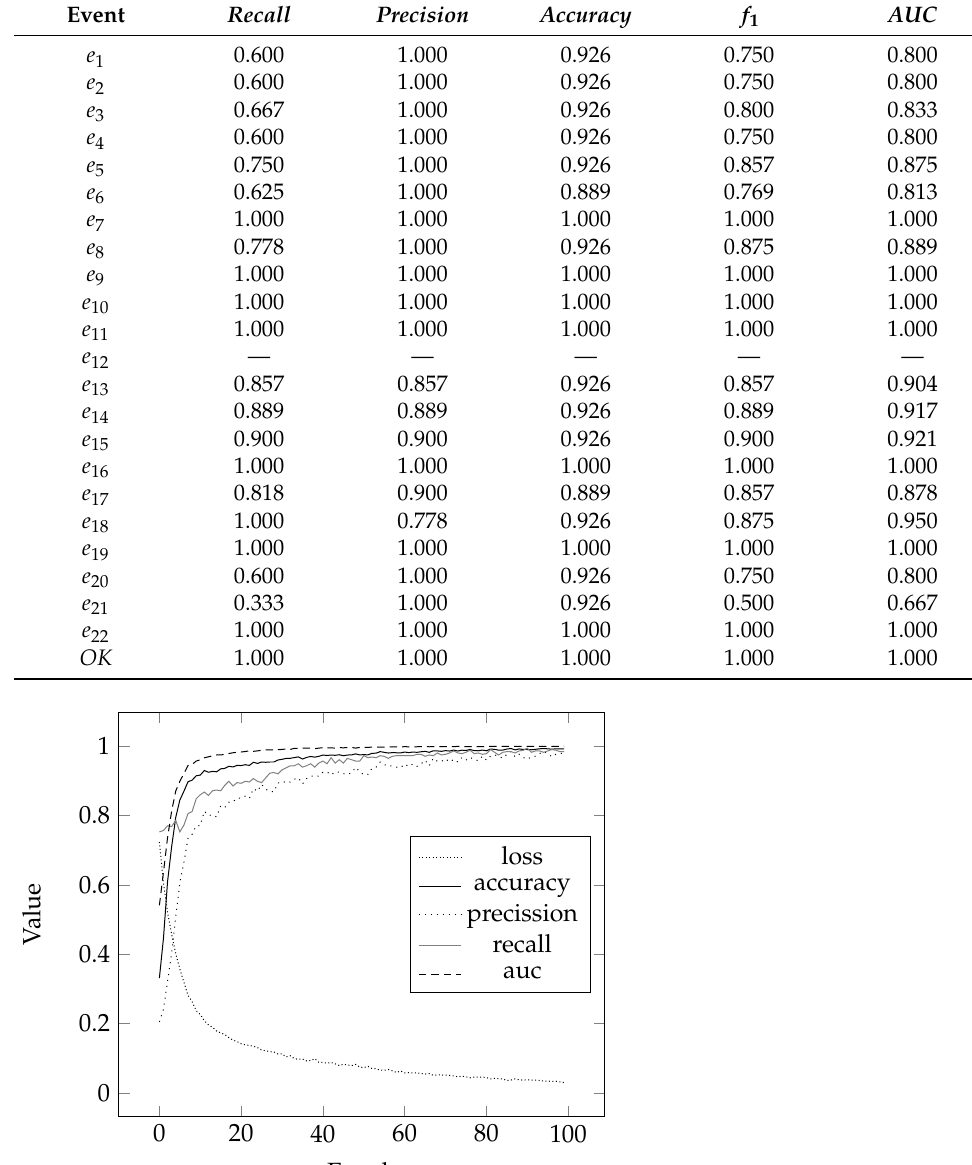
Table 7. Performance results for the developed random forests model in a test dataset.